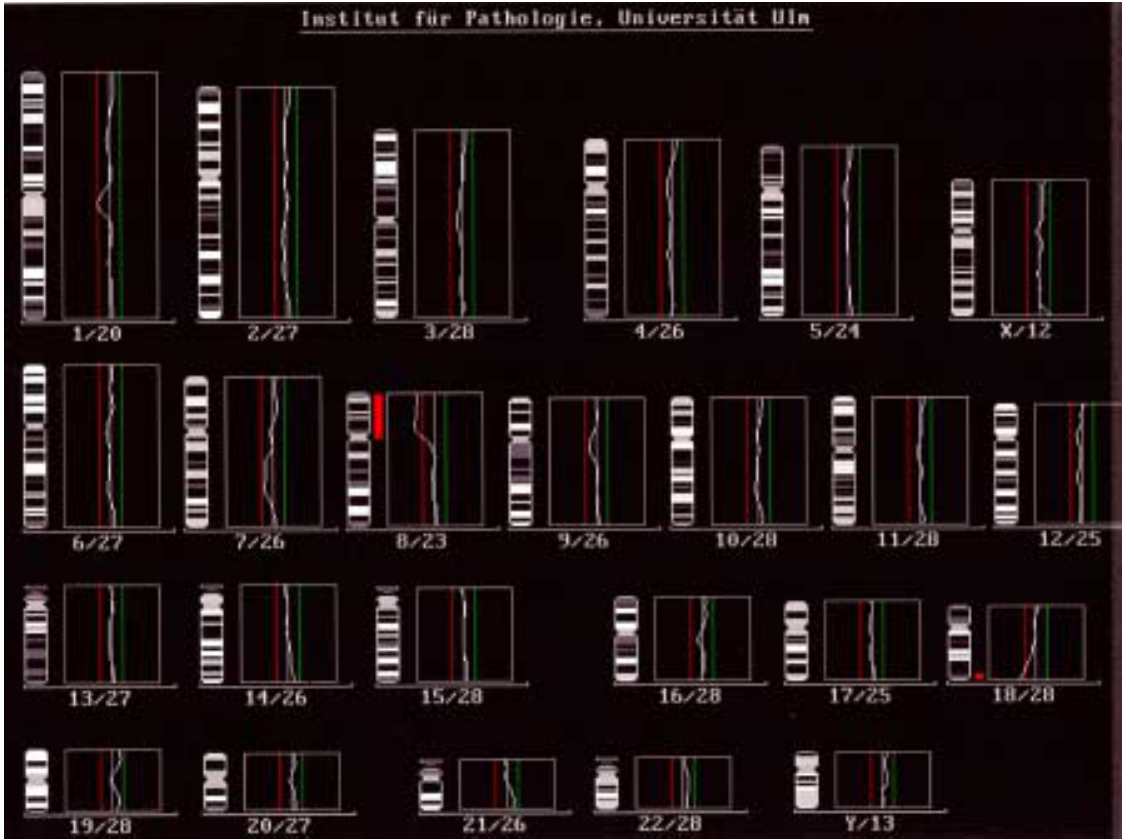
Fig. 2. Example of the CGH analysis. Ratios of the fluorescence intensities generated by tumour and control DNA were obtained from 15 metaphase cells, and the average ratio profile was plotted along each single chromosome. The three vertical lines next to each ideogram indicate the balanced state of the chromosomal copy number (central line, ratio value 1.0) as well as the diagnosis thresholds (red line, ratio value 0.8; green line, ratio value 1.25) indicating chromosomal losses or gains, respectively. Red bars on the left of the chromosomes indicate DNA loss, and green bars on the right indicate DNA gains (here not shown). This figure can be viewed on